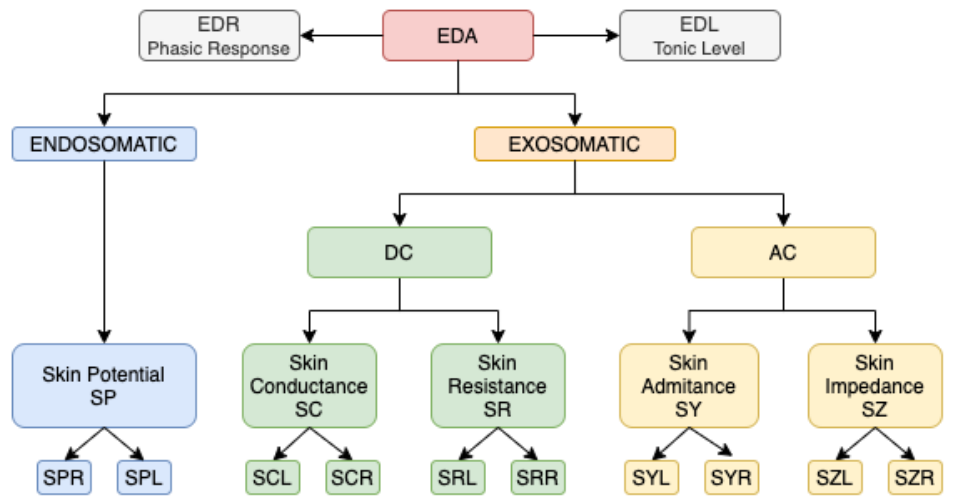
Figure 5. Contemporary labelling of electrodermal activity, inspired in [105].